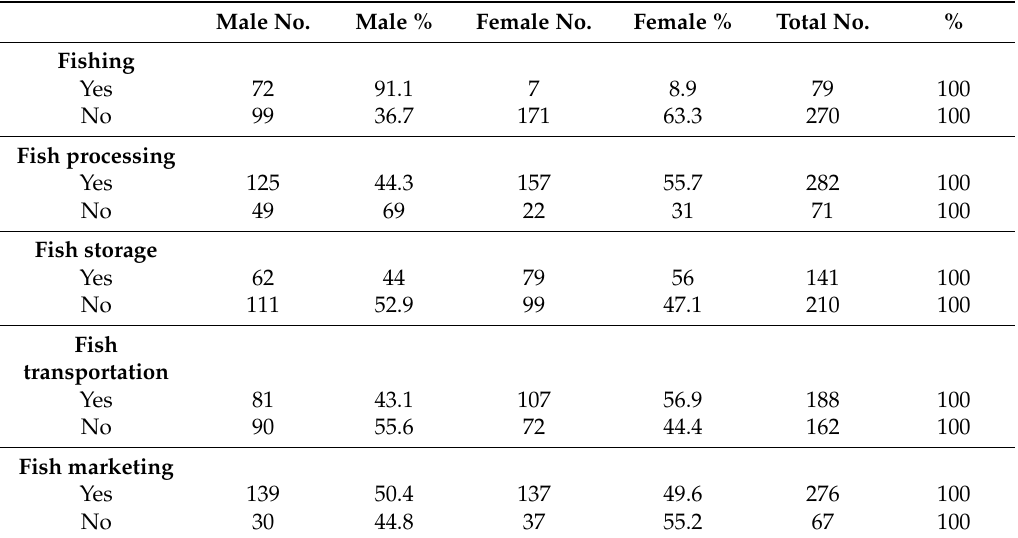
Table 6. Men and women’s participation in decision making in fishing related